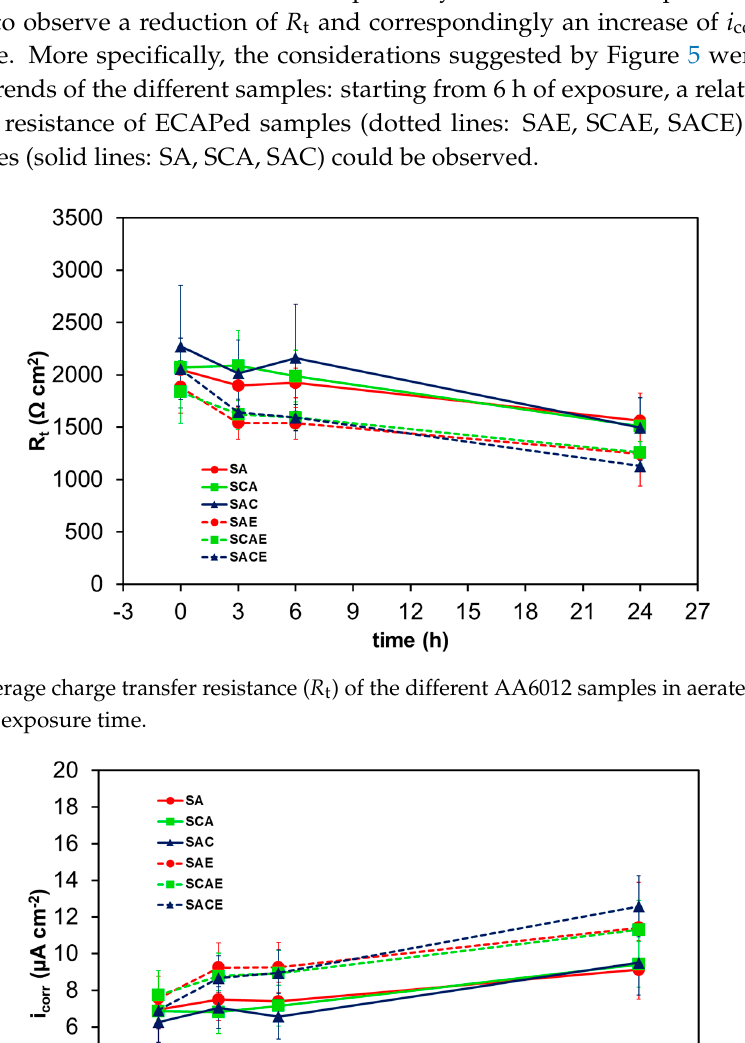
Figure 6. Equivalent circuit used for fitting electrochemical impedance spectroscopy (EIS) experimental data.